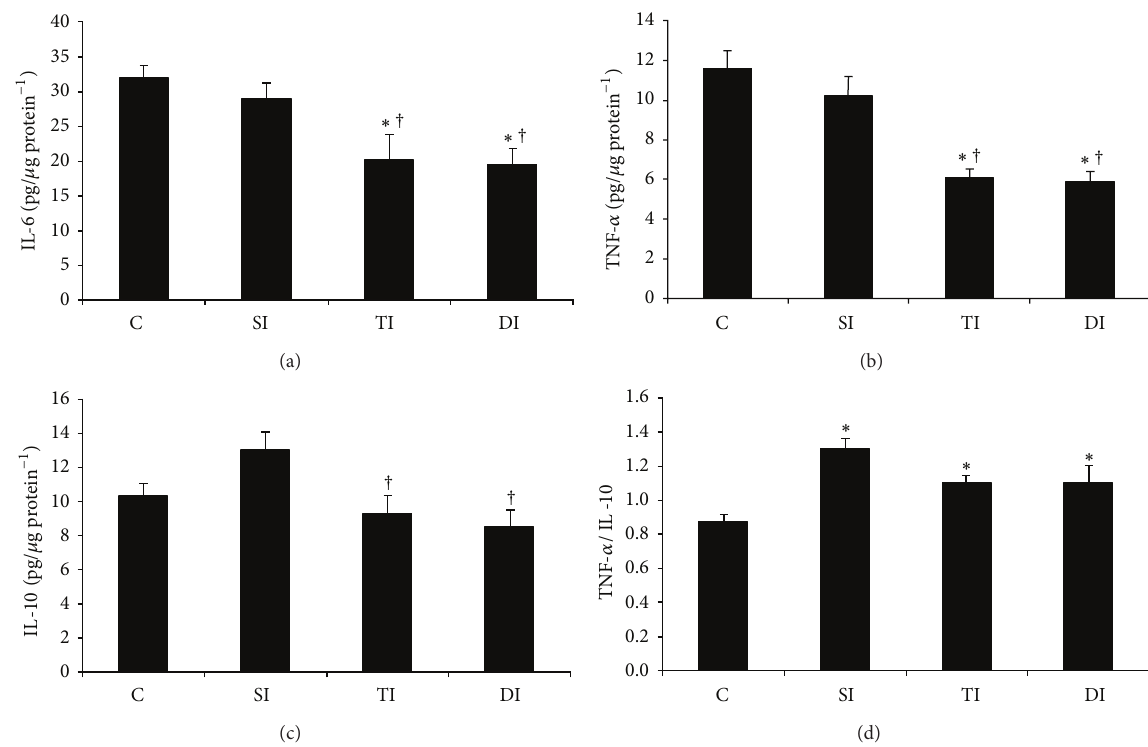
Figure 3: Inflammatory profile on epididymal adiposetissue of control (C), sedentary infarcted (SI), trained infarcted (TI), and detrained infarcted (DI) rats. ∗ 𝑃 < 0.05 versus C; † 𝑃 < 0.05 versus